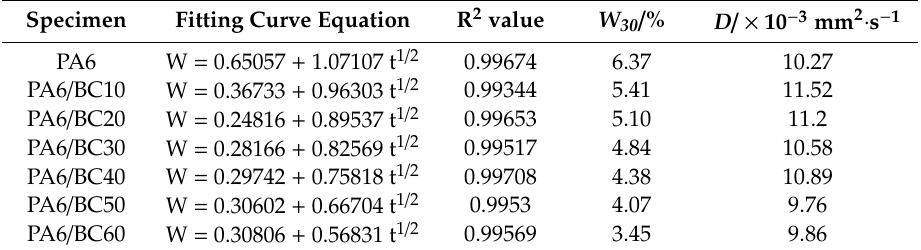
Table 1. Parameters of water absorption kinetics for fitting curves based on Fick’s second law.